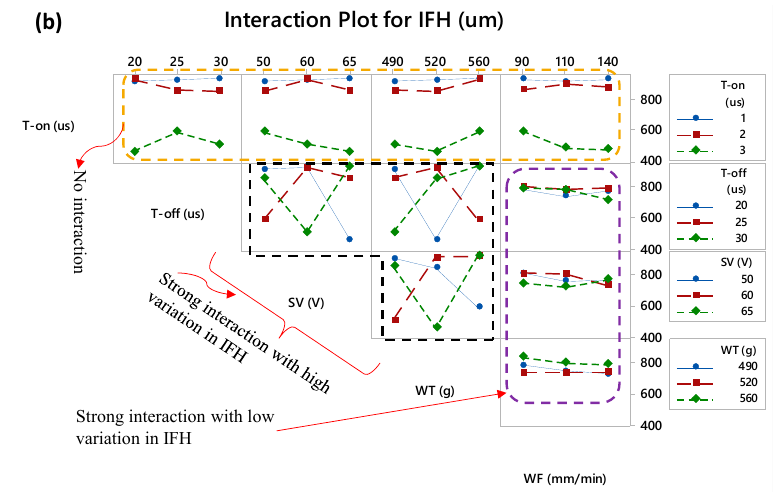
Figure 6. Parametric effects on inter-channel fin thickness (IFH): ( a ) main effects plot and ( b ) interaction plot. Table 7. S/N ratio analysis of IFH (Larger is better).